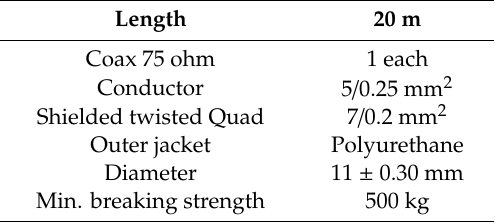
Table 7. Specification table for underwater LED light source.